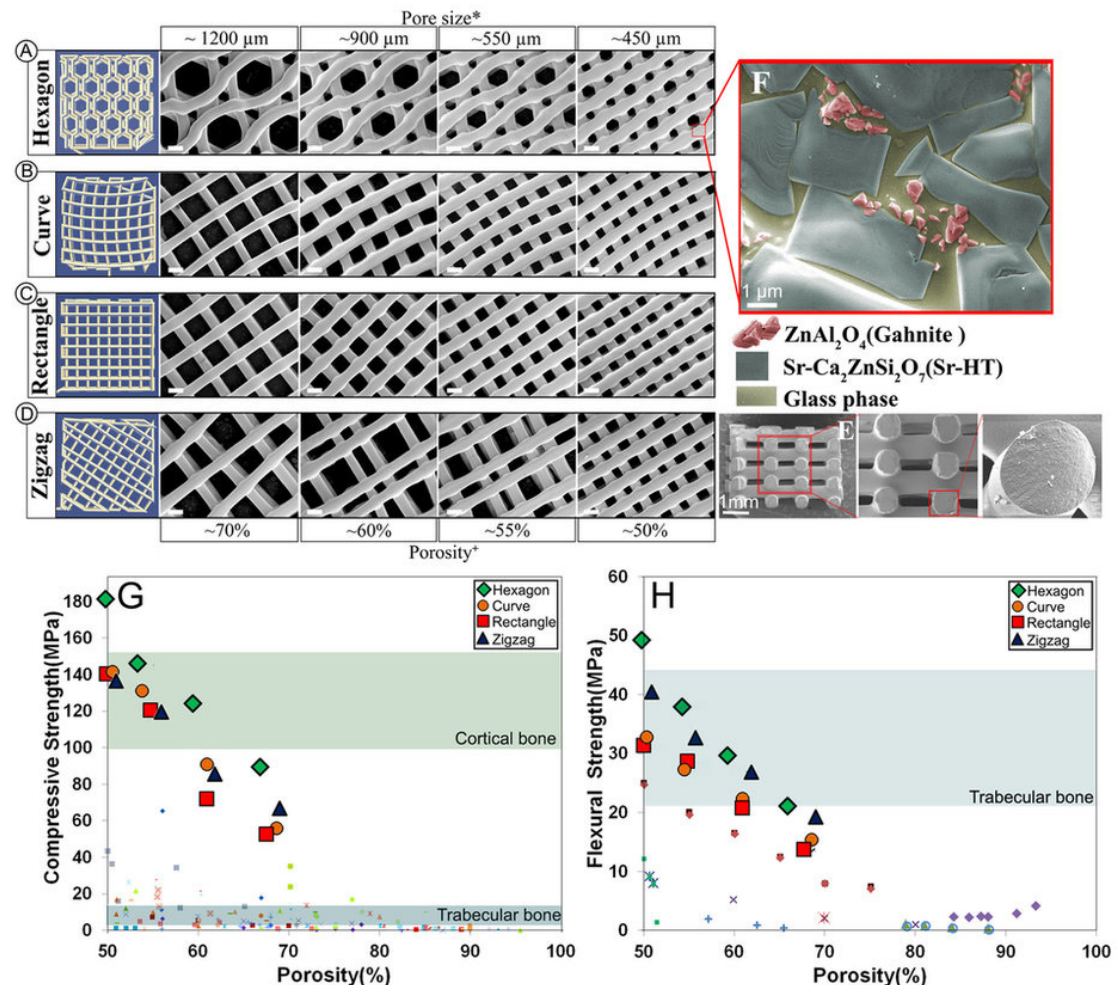
Figure 7. Sr-HT-Gahnite is a multiphasic ceramic produced by co-sintering of Sr-hardystonite with 15 wt% alumina. ( A – D ) Sr-HT-Gahnite scaffolds with a range of controlled geometries could be fabricated by 3D printing, all of which exhibited a unique microstructure featuring ( E ) solid struts and ( F ) three different phases. The ( G ) compressive strength and ( H ) flexural strength of 3D printed Sr-HT-Gahnite scaffolds greatly exceeded the values exhibited by other bioactive ceramic scaffolds at comparative porosities, and were within the ranges of values reported for human bone [66].